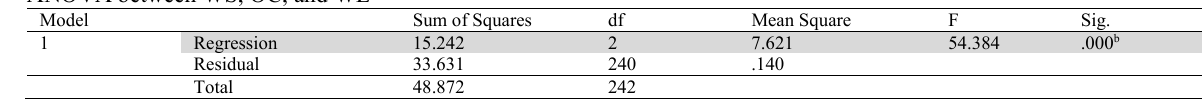
According to Table 15, work spirituality and organizational commitment simultaneously influenced on work